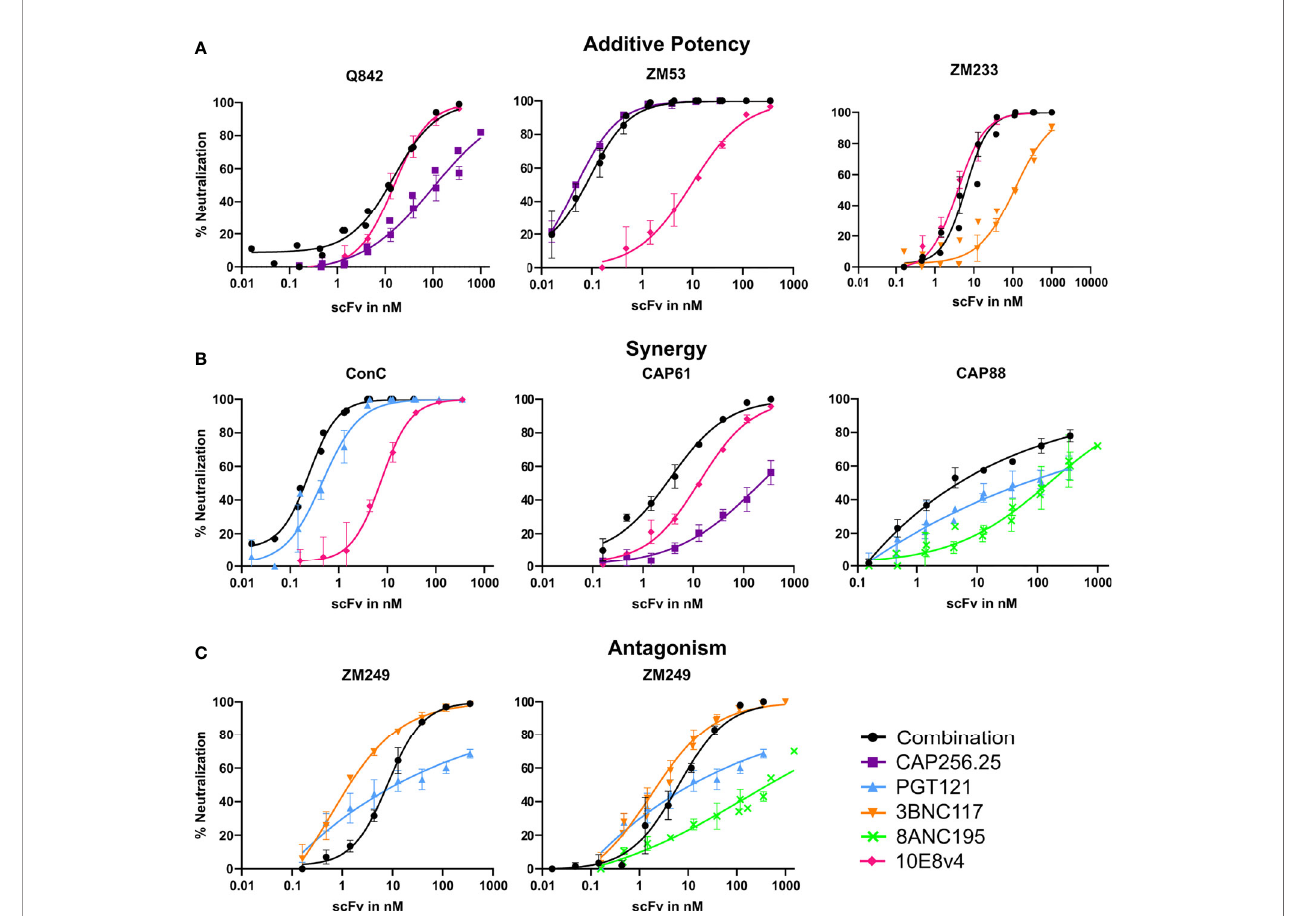
FIGURE 2 | Combinations of scFv that show improved neutralization potency over single scFv. Neutralization curves showing potential additive, synergistic and antagonistic potency effects of combinations of antibodies. Combinations of scFv compared to single scFv neutralization curves with CAP256.25 in purple, PGT121 in light blue, 3BNC117 in orange, 8ANC195 in green and 10E8v4 in pink. The dual or triple combinations are represented in black. Geometric mean values are used for each data point with error bars representing repeat experiments. (A) Examples of combinations where neither synergy nor antagonism is observed for three viruses tested against dual combinations of scFv. Additive potency is represented by the combination curve (black) overlapping with the best scFv in the mixture. (B) Potential synergy as observed in dual combinations of scFv against three different virus strains. Synergy was represented by a left shift of the combination curve (black) relative to the most potent scFv in the mixture, or by steeper neutralization curves resulting in improved IC80. (C) Potential antagonism as represented by a right shift of the combination curve relative to the most potent scFv in the mixture, observed in combinations of two or three scFv tested against ZM249, which was sensitive to all scFv in